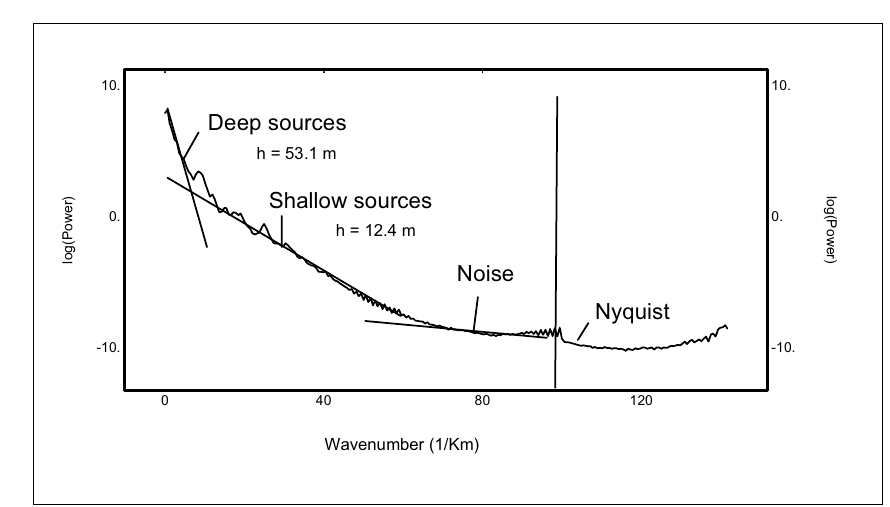
Fig. 5. Radially averaged power spectrum and depth estimate of the total intensity magnetic map of the Abu- Shihat radioactive prospect area, North Eastern Desert, Egypt.